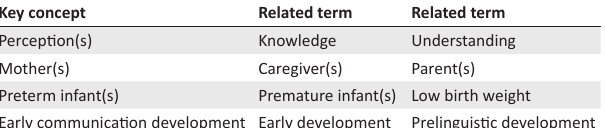
TABLE 1: Summary of key concepts and related terminology . Key concept